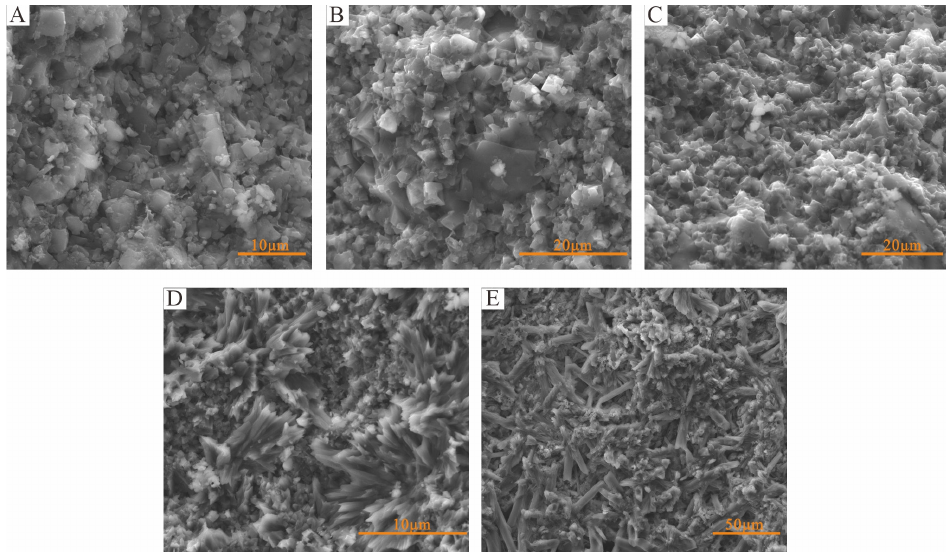
Figure 6. Scanning electron microscope (SEM) images of the lower member of Xingouzui Formation ( A – C ) Dolomite well CY1, 2701.04 m, 2702.86 m, 2709.73 m ( D , E ) Glauberite well CY1, 2700.65 m, 2706.09 m.